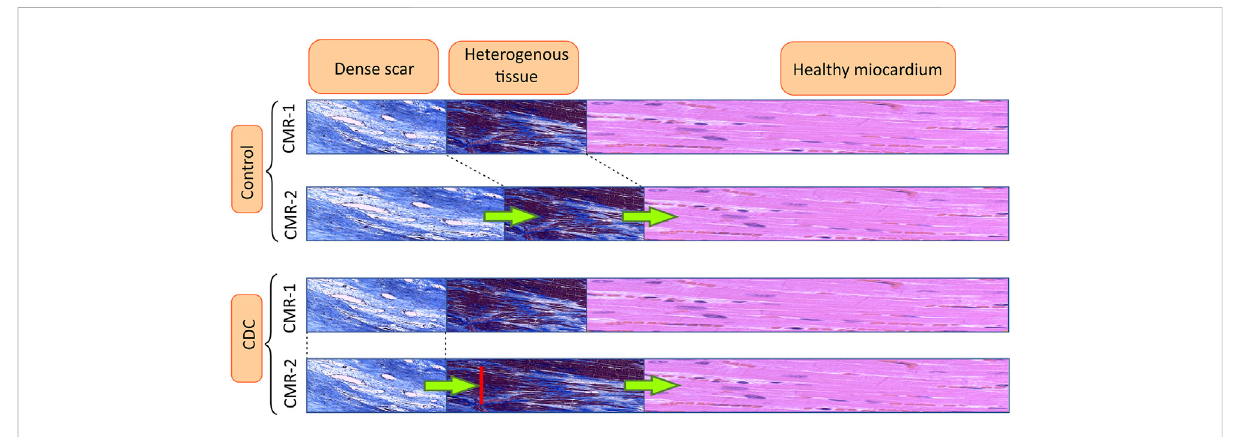
FIGURE 8 CDCs block the conversion of HT to DS in the epicardial scar. This diagram shows the evolution of the scar depending on the treatment group. Abbrv: CMR = cardiac magnetic